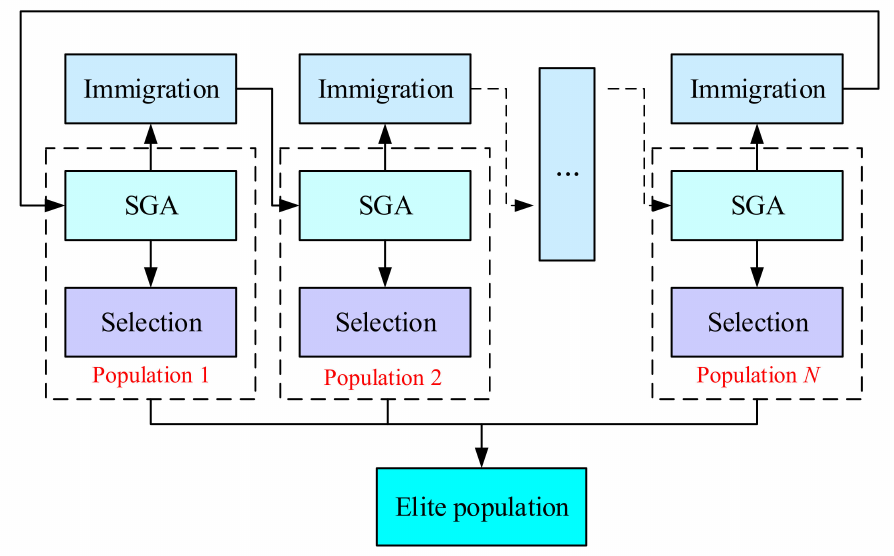
Figure 4. Structure of multi-population genetic